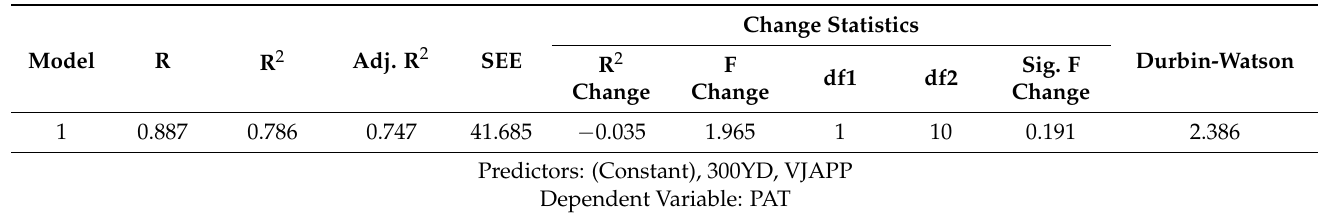
Table 5. Model Summary—Predicting PAT Scores from AF Parameters and/or MT Levels.